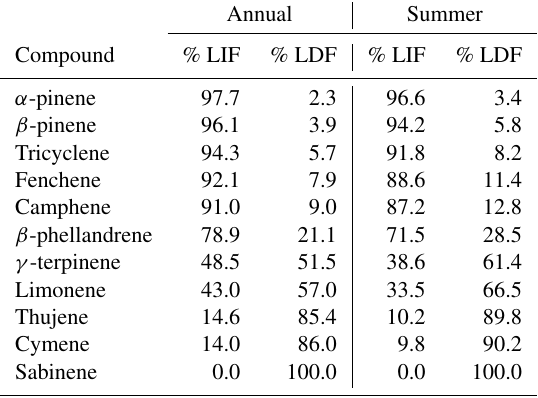
Figure 4. A 4d period in July 2020 of isoprene and the two PMF factors (light dependent and light independent).